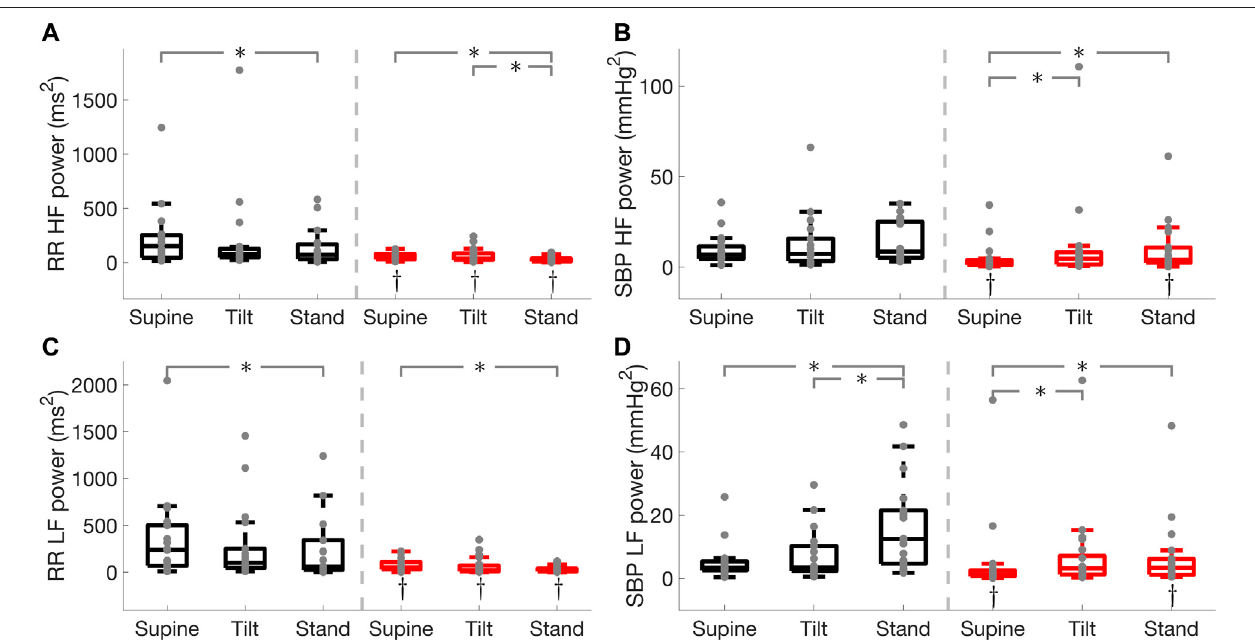
FIGURE4| RRintervalandsystolicbloodpressure(SBP)spectralpowerinthehigh(HF)andlow(LF)frequencybandsinParkinson ’ sdiseaseandhealthycontrols. RRintervalHFpower (A) ,SBPHFpower (B) ,RRintervalLFpower (C) ,SBPLFpower (D) .*illustratesasigni fi cancedifferenceformultiplecomparison(post-hocanalysis withBonferroniadjustment)betweensupine,tilt,andstandinginParkinson ’ sdiseasepatients(red)andhealthycontrols(black),while † representsasigni fi cantdifference (Wilcoxon rank sum test) between Parkinson ’ s disease patients and healthy controls.